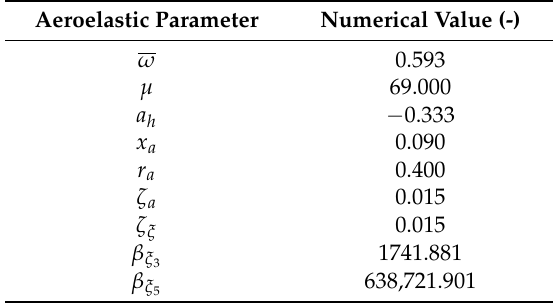
Table 1. Aeroelastic parameters representative of the wind tunnel test rig [22].